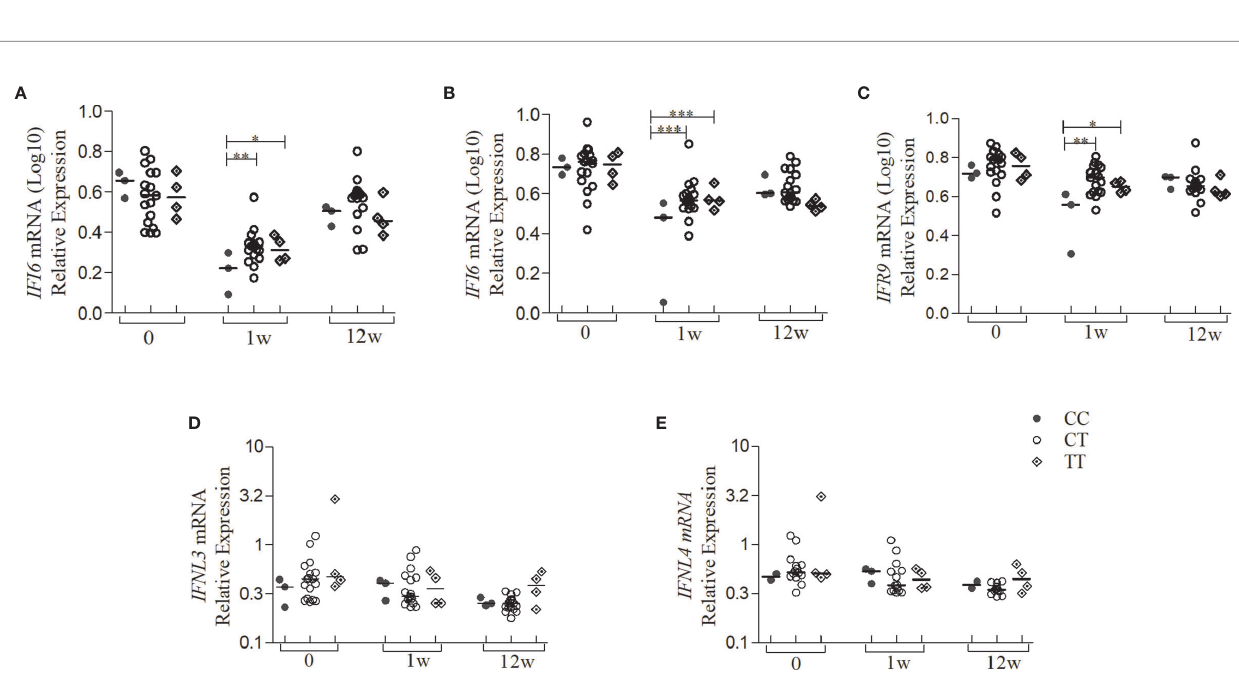
FIGURE 4 | Gene expression levels of the type I IFN signaling pathway and type III IFN of patients with CHC treated with Peg-IFN a /RBV strati fi ed by the SNP genotype rs12979860. Quanti fi cation of the expression of the IFN type I signaling pathway genes from whole blood of patients with CHC (n = 24) treated with Peg- IFN a /RBV at times 0, 1, and 12 weeks of treatment. (A) IFI6 ; (B) IFI16 ; (C) IRF9; (D) IFNL3 ; (E) IFNL4 mRNA expression. Expression of other genes analyzed did not present statistically signi fi cant results. Statistical analysis was performed by Kruskal-Wallis test and Dunn ’ s multiple comparison test by each genotype in the same group and between the groups 0, 1w, and 12w (*P < 0.01, **P < 0.001, ***P < 0.0001). w, week; wpt, week